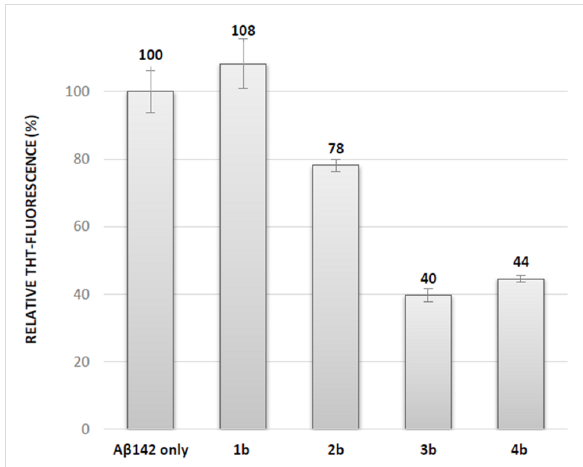
Figure 4: Effects of compounds 1–4 on A β 1-42 fibrillization assessed by ThT-fluorescence spectroscopy at 10:1 compound/A β ratios (the concentration of A β 1-42 is 10 μ M) and compared to the values ob- tained for A β 1-42 alone. (See Supporting Information File 1 for the calculation of the change of fluorescence intensity at the